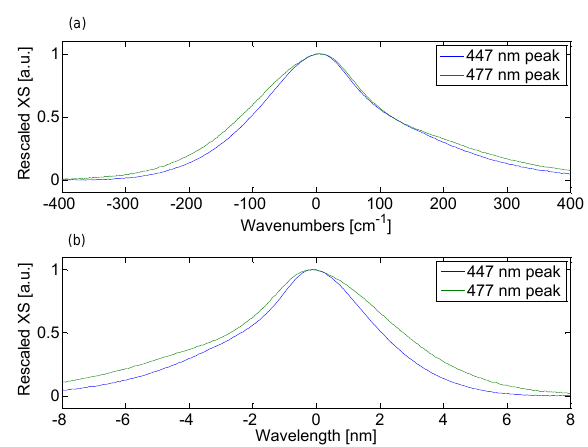
Figure 1. Shifted ( a by wave number; b by wavelength) and nor- malized O 4 absorption cross sections at 446 and 477nm according to Thalman and Volkamer